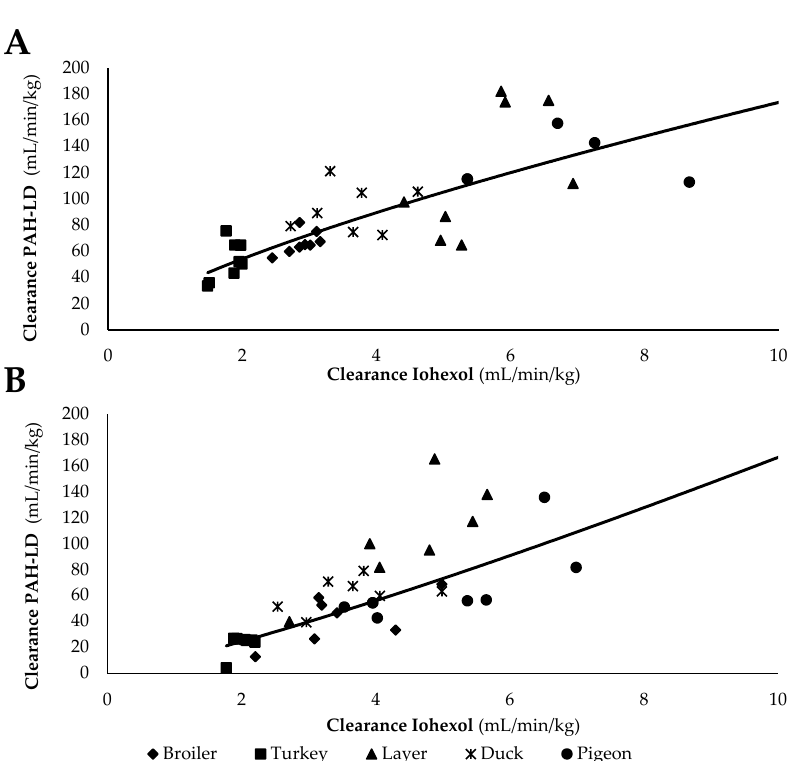
Figure 2. ( A ) Correlation between para-aminohippuric acid low dose (PAH-LD) clearance (mL/min/kg) and iohexol clearance (mL/min/kg). ( B ) Correlation between para-aminohippuric acid high dose (PAH-HD) clearance (mL/min/kg) and iohexol clearance (mL/min/kg) in different poultry species (broiler, turkey, layer, duck, and pigeon) ( n = 8). The PAH-LD clearance is an estimate of the effective renal plasma flow, and the PAH-HD clearance is an estimate of tubular secretion. The iohexol clearance is a marker of the glomerular filtration rate.